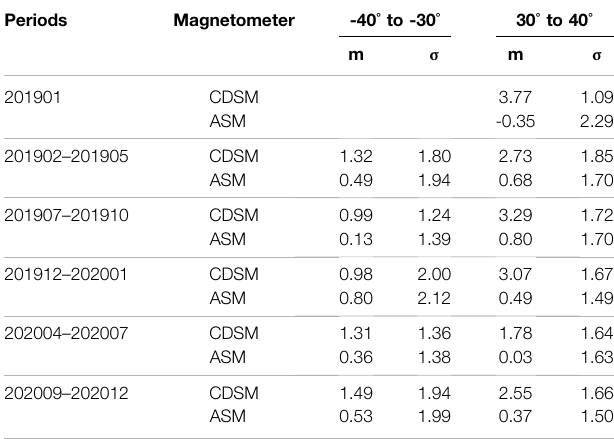
TABLE 2 | Results of data in dipole latitude range of -40 ° to -30 ° and 30 ° to 40 ° on the night side. Periods Magnetometer